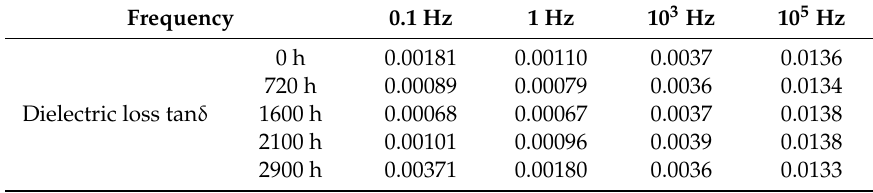
Table 1. E ff ect of thermal aging on dielectric loss tan δ in the low- and high-frequency